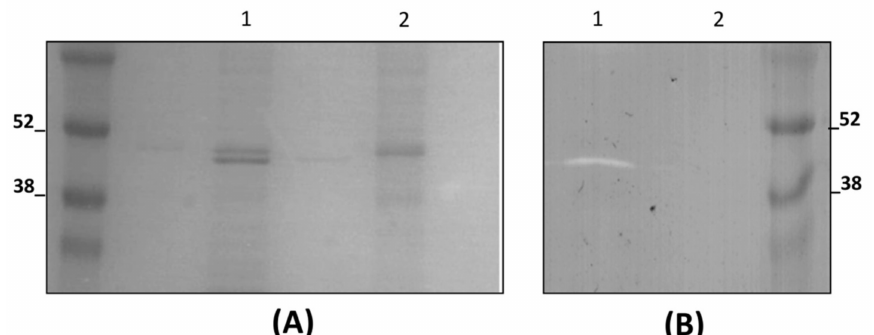
Figure 4. Detection of LysTP712 activity. ( A ) SDS-PAGE analysis of purified His-tagged LysTP712 (Fraction I) expressed in L. lactis NZ9000 in the absence (lane 1) or presence (lane 2) of 5 mM sodium azide (NaN 3 ). ( B ) Zymogram showing hydrolytic activity of purified LysTP712 expressed in the absence (lane 1) or presence of NaN 3 (lane 2) in L. lactis NZ9000 cells. Faint bands in unlabeled lanes in ( A ) are due to well-to-well overflow.